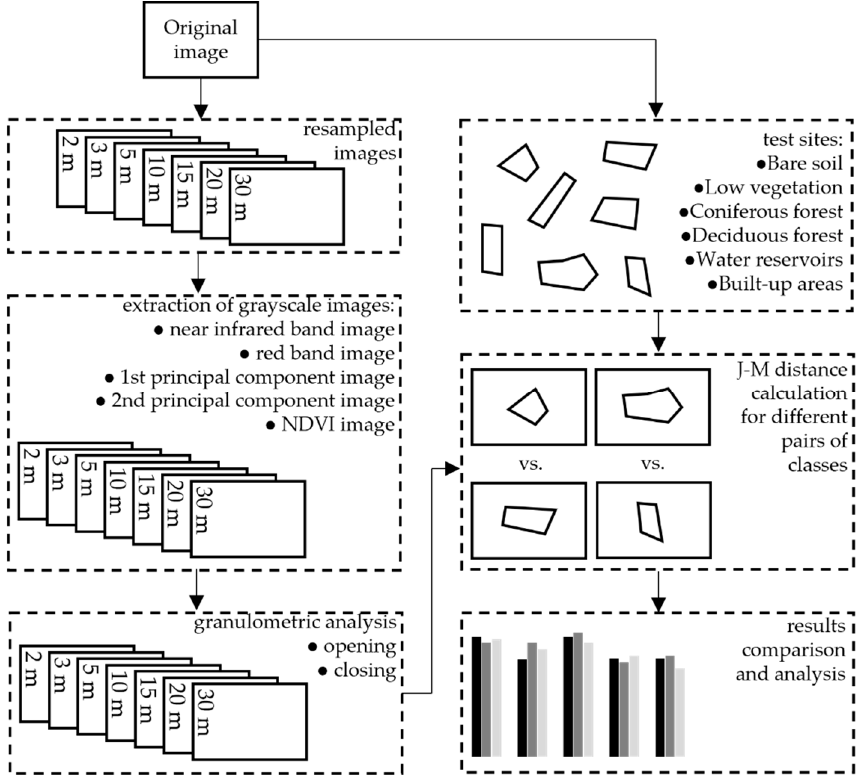
Figure 2. Scheme of research methodology.